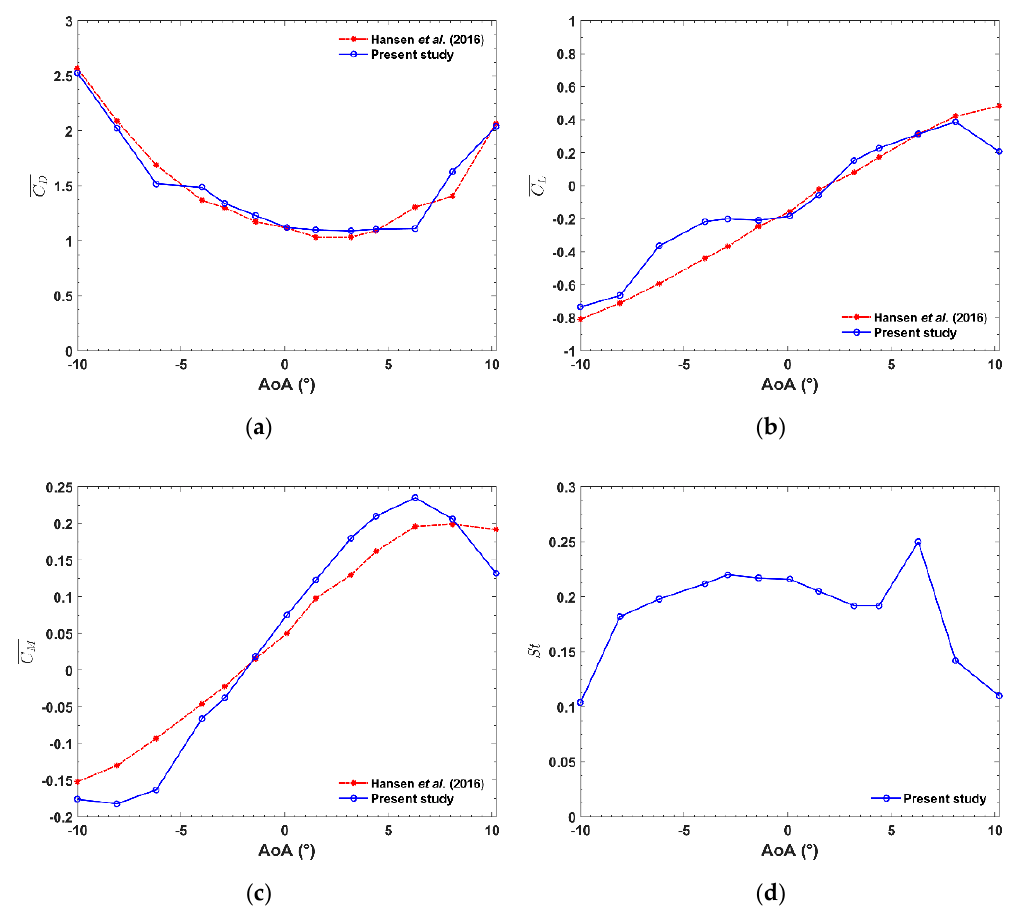
Figure 5. Variation of aerodynamic quantities with respect to AoA: ( a ) time-averaged drag coe ffi cient C D , ( b ) time-averaged lift coe ffi cient C L , ( c ) time-averaged moment coe ffi cient C M and ( d ) Strouhal number S t